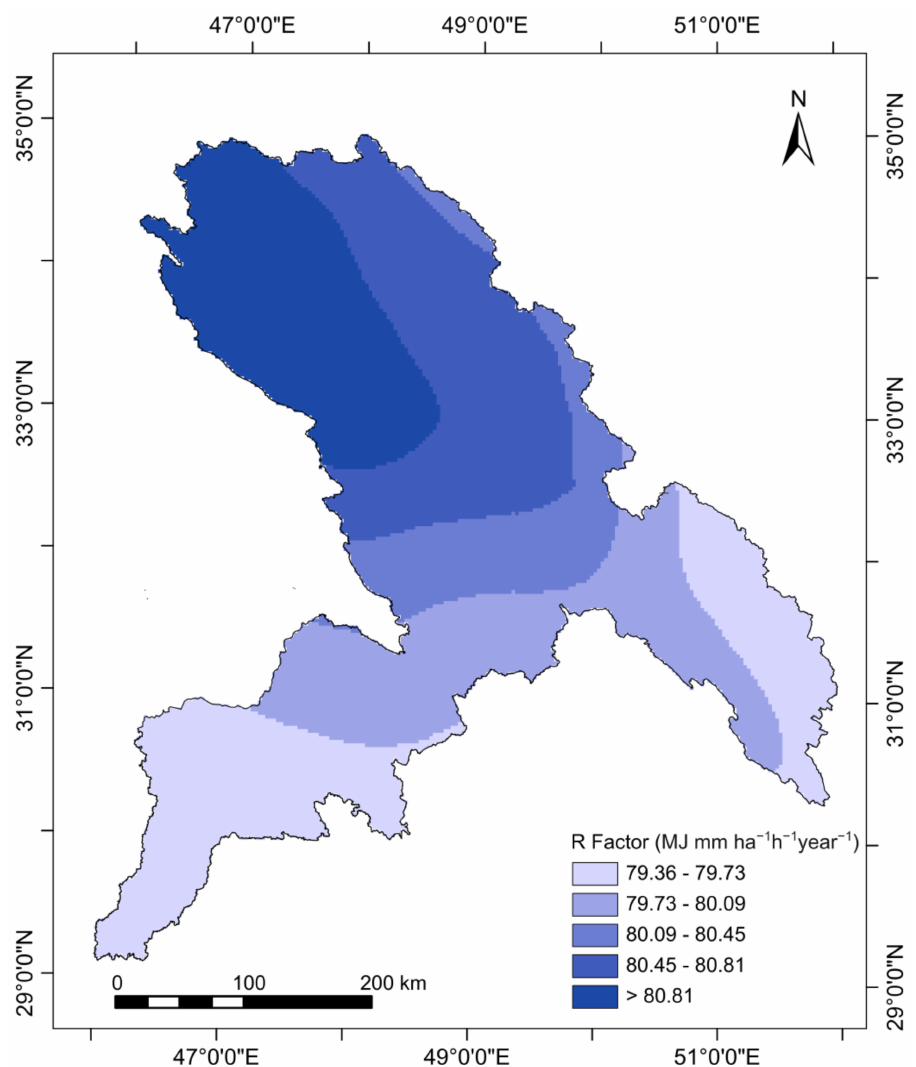
Figure 3. Spatial distribution of R factor in the study